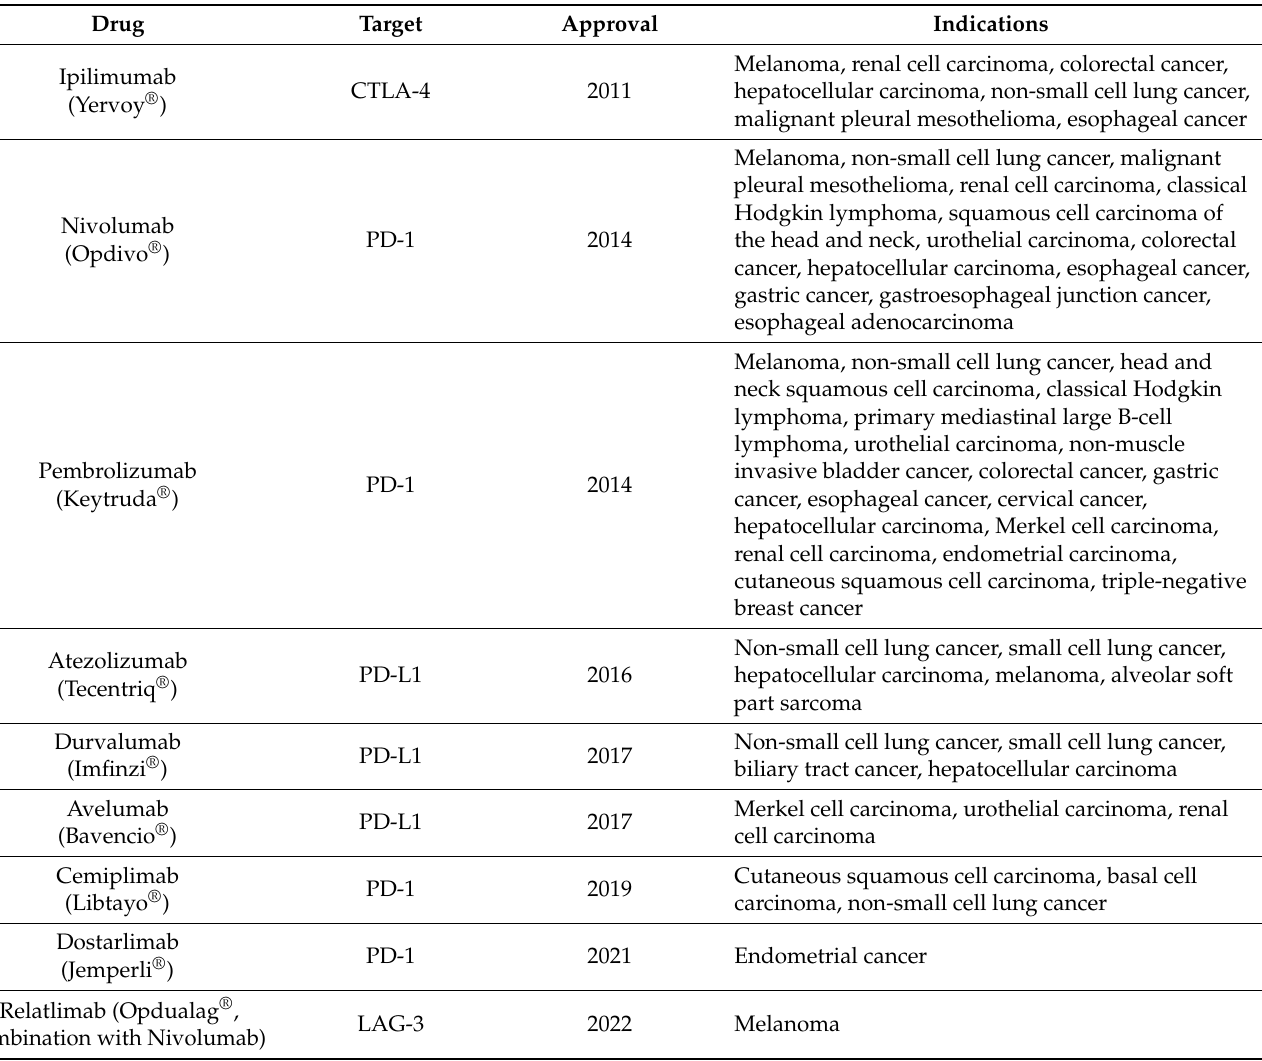
Table 1. FDA-approved immune checkpoint inhibitors with approved indications (as of February